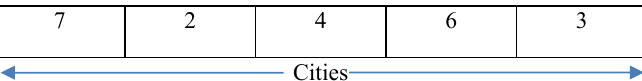
Fig. 4. An arbitrary OTSSP solution with 6 out of 8 cities